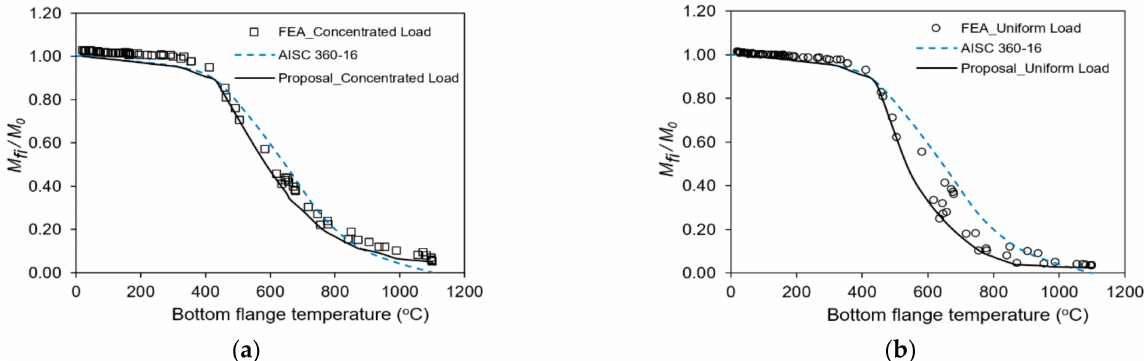
Figure 16. Comparison between FEA results and proposal equation: ( a ) LC1; ( b ) LC2.